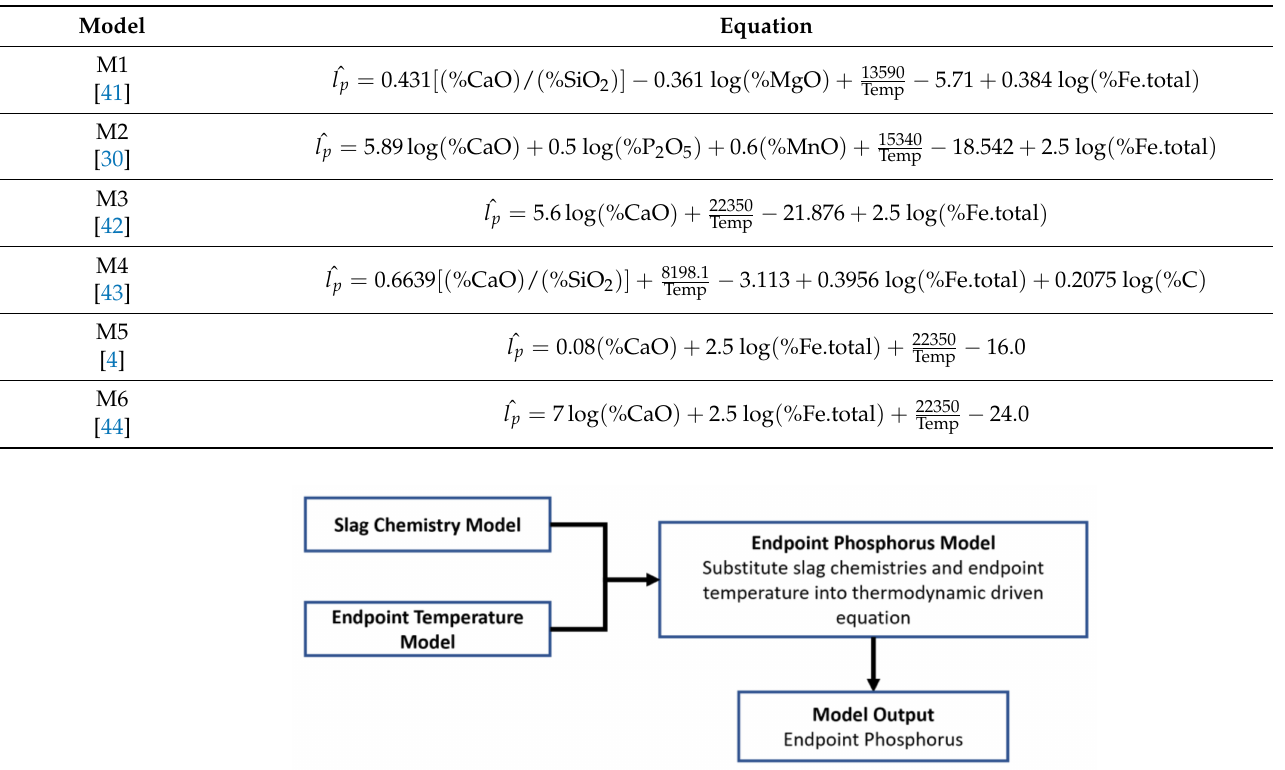
Figure 5. Flowchart of the endpoint phosphorus theoretical